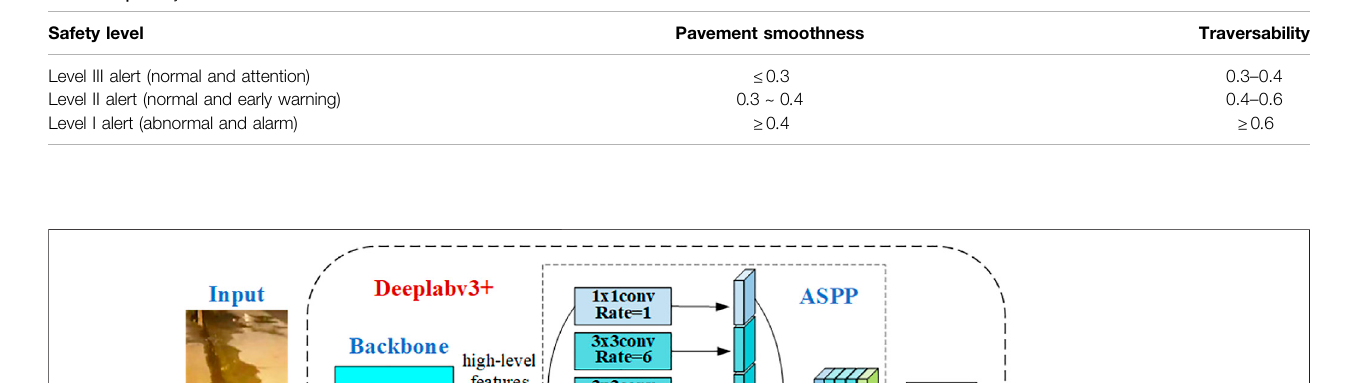
TABLE 1 | Safety classi fi cation of the internal structure of the cable trench.